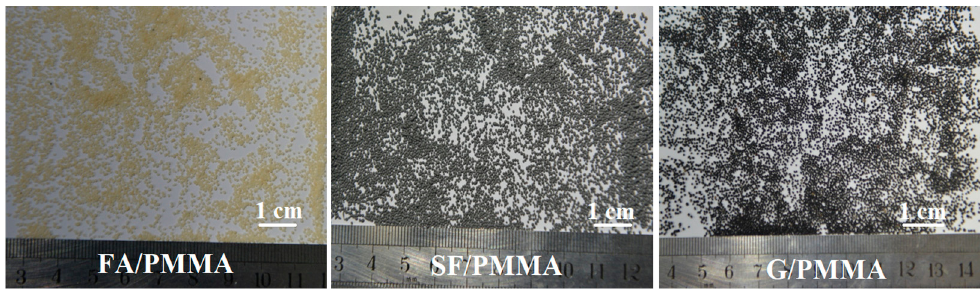
Figure 8. Hydraulic fracture propped with proppant of ( a ) large, ( b ) medium, ( c ) small size [9].